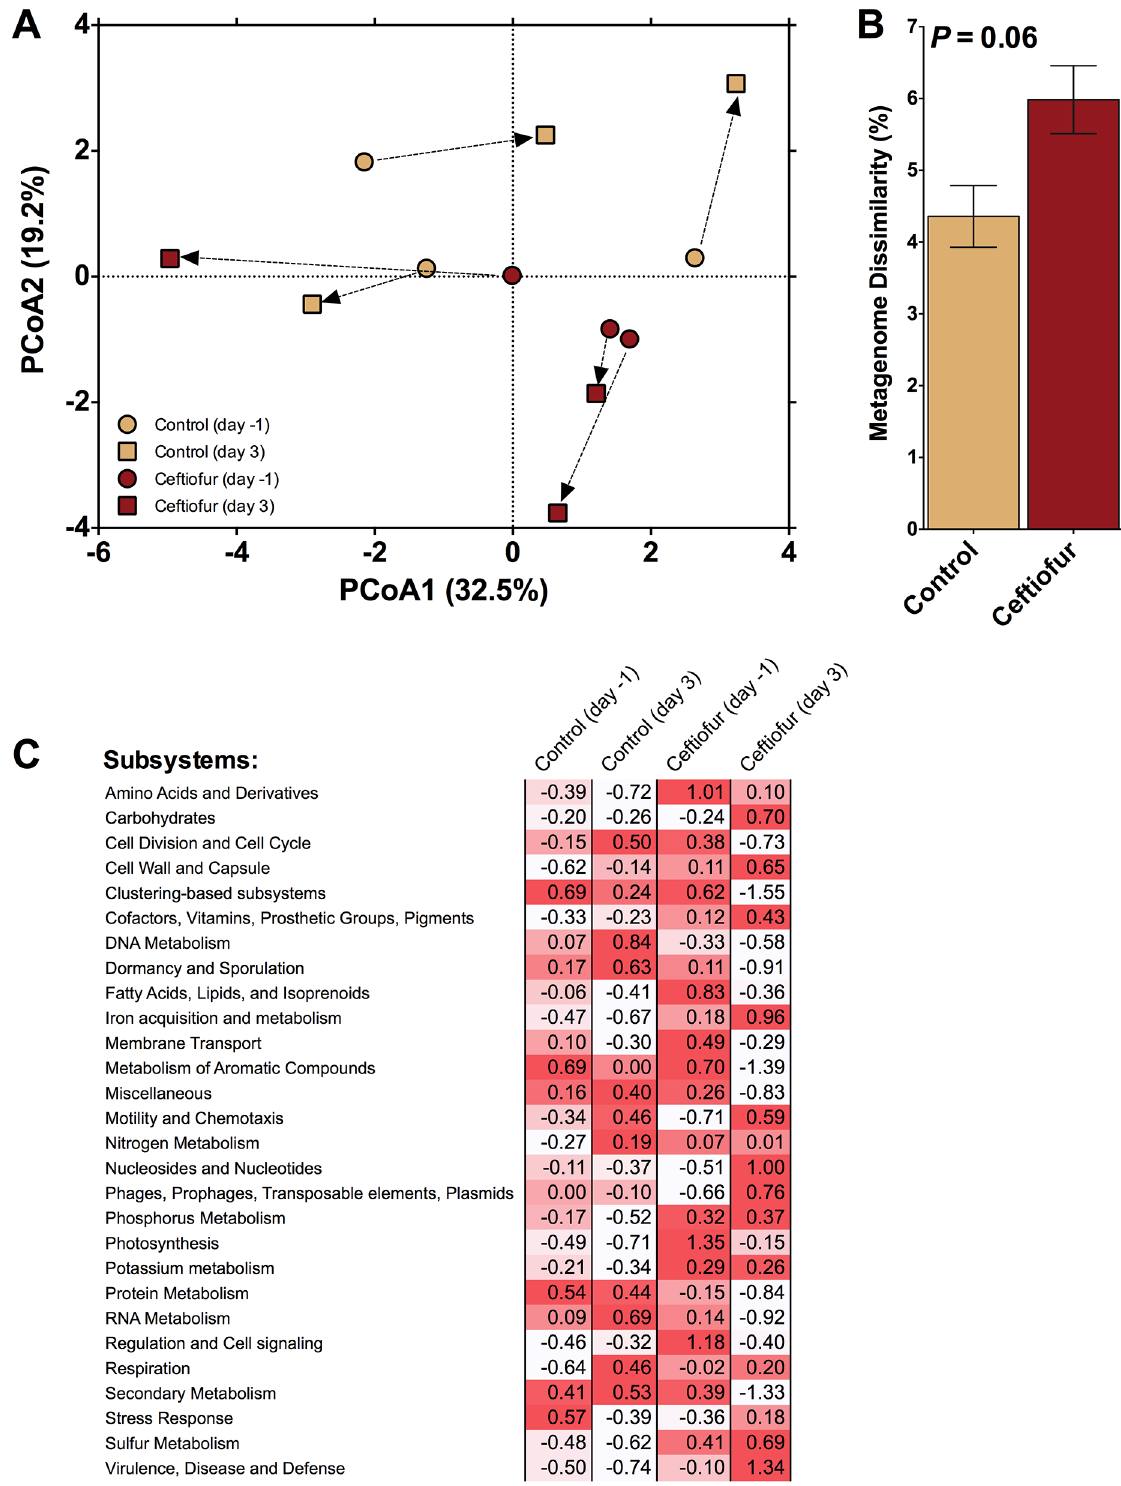
Fig 4. Comparison of metagenomes. A) Principal component analysis illustrating Bray-Curtis distance between initial metagenomes and those after 3 days of either exposure or no exposure to the antibiotic ceftiofur. Arrows indicate the change in communities associated with individual cows. B) Dissimilarity after 3 days between the fecal derived metagenomes of control and ceftiofur treated cows. C) Standard scores (i.e. z-scores) compared across treatments within a given subsystem. Note: Red intensity of z-scores indicates relative increase from the mean associated with that